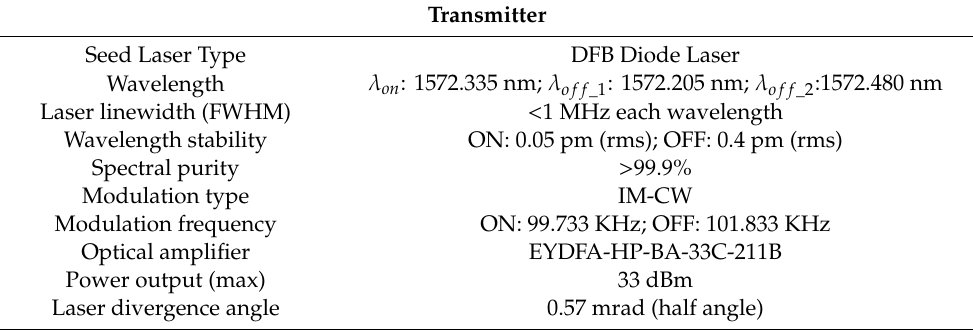
Figure 1. The system configuration for the first trial. PMF, polarization maintaining fiber; SMF, single-mode fiber; DDS, direct digital synthesis; PID, proportional-integral-differential control system; AOM, acoustic-optic modulator; EDFA, erbium-doped fiber amplifier. Table 1. Primary parameters of the 1.57 µ m intensity modulated, continuous-wave (IM-CW) integrated path differential absorption (IPDA) lidar system.